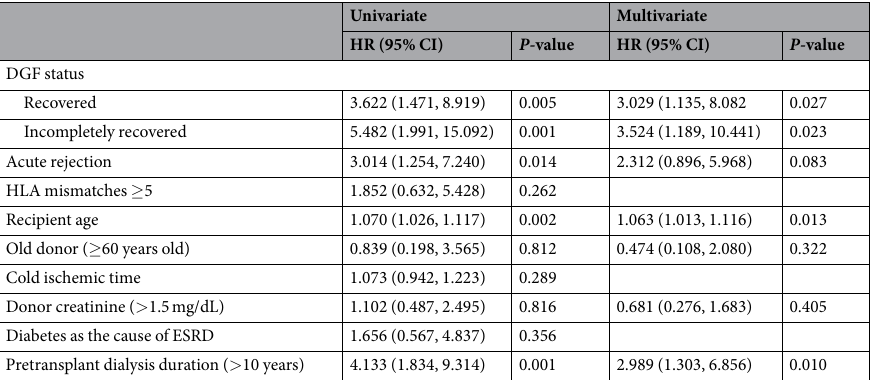
Table 3. Risk factor analysis for patient death. DGF = delayed graft function, ESRD = end stage renal